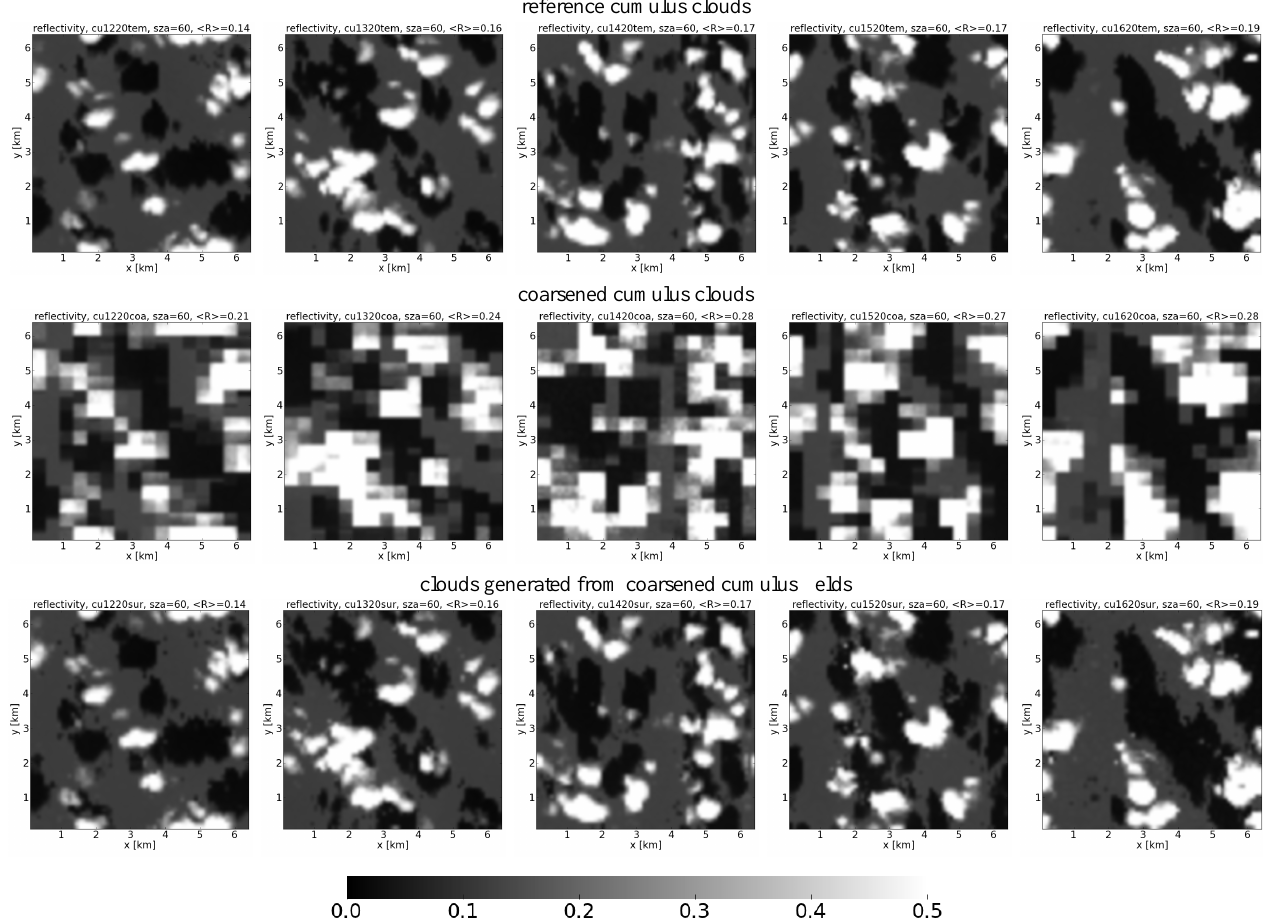
Fig. 5. Reflectivity fields of some selected scenes of the cumulus diurnal cycle presented in Sect. 3. The sun illuminates the scenes from the south at a zenith angle of 60 ◦ . Otherwise, the figure is the same as Fig. 4. Notice the similarity in the top and bottom row fields indicating the convenience of calculating the radiative transfer at spatially high-resolved cloud fields.